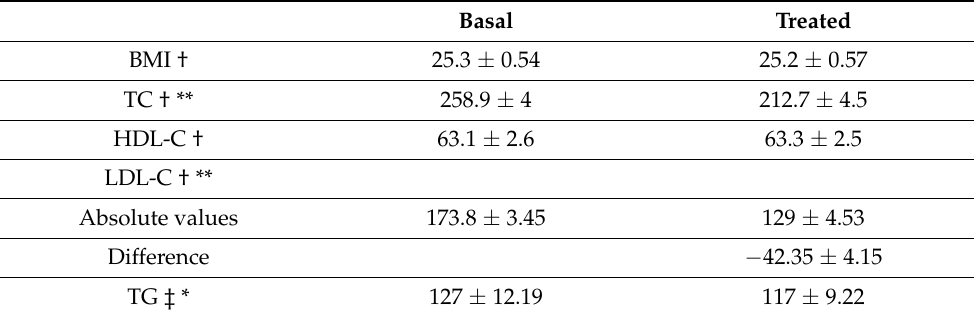
Table 3. Comparison of variables before and after 8 weeks of